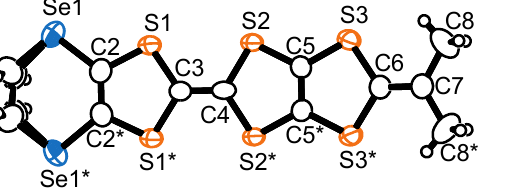
Figure 5. Crystal structures of 4 ( a ) viewed along the c axis and ( b ) b axis. Blue broken lines indicate the Se···Se contacts, shorter than the sum of the van der Waals radii; ( c ) Top view and side view of molecular overlap of c . The atoms in the front molecule are represented by solid circles and those in the rear are represented by open circles. One of the conformations for the ethylene bridge is omitted for clarity.